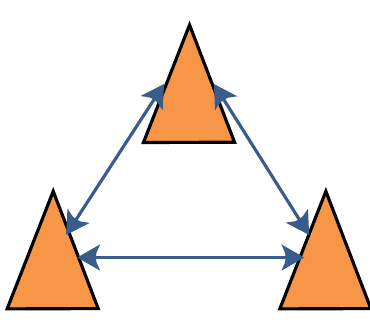
Figure 4. Communication graph for